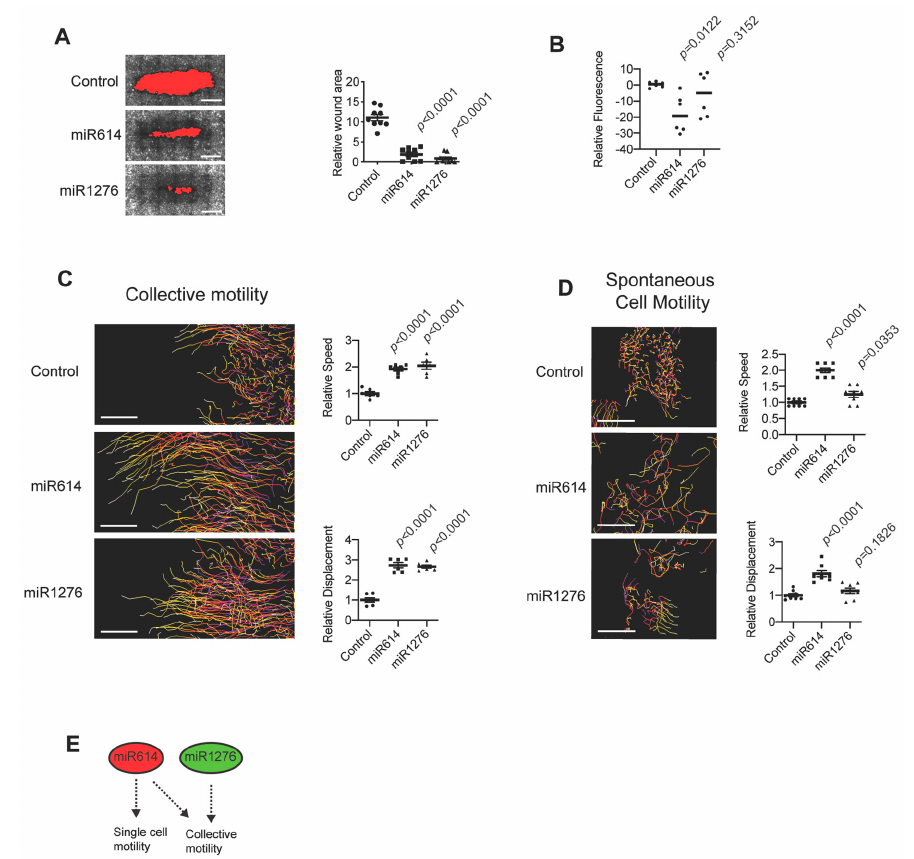
Figure 1. miR614 enhances migration. ( A ) Representative images of MCFDCIS cells stained with phalloidin showing that transfection of miR614 or miR1276 mimics enhances the rate of wound closure over 24 h. The wound area, indicated in red, is determined by fluorescent signal threshold analysis that defines cell-free space. Graph shows the quantification of wound area. Less wound area indicates faster migration. n = 9 wells imaged in 3 independent experiments. Scale bars, 1 mm. ( B ) Transfection of miR614 or miR1276 does not increase proliferation. Graph shows the fluorescence intensity of Hoechst stained cells after completion of a 24 h wound closure assay. n = 6 wells from 2 independent experiments. ( C ) MCFDCIS cells transfected as indicated were wounded and imaged for 7 h. Tracking of cell movement is shown. Color changes indicate increasing time. Scale bars, 100 µ m. Graphs show quantification of cell speed and displacement (mean ± SD, n = 6 x,y positions over 2 independent experiments). ( D ) Subconfluent MCFDCIS cells transfected as indicated were imaged for 7 h. Tracking of cell movement is shown. Color changes indicate increasing time. Scale bars, 100 µ m. Graphs shows quantification of cell speed displacement (mean ± SD, n = 6 x,y positions over 2 independent experiments). ( E ) Model showing that miR614 promotes single cell and collective migration while miR1276 specifically promotes collective migration. p -values determined by unpaired Student’s t